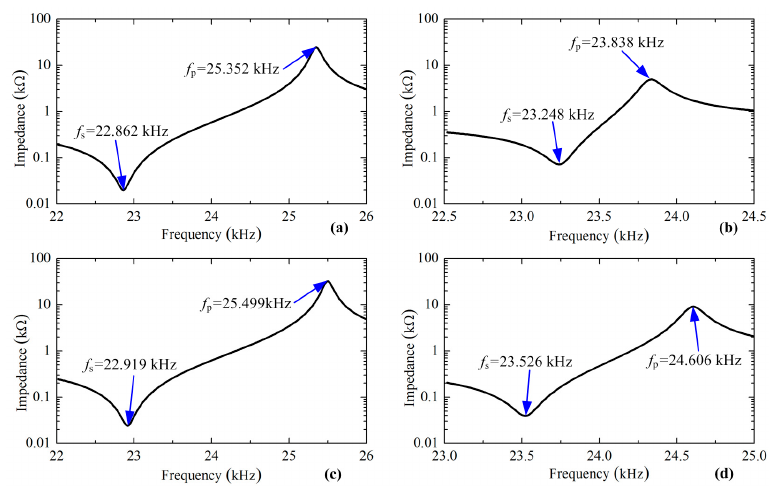
Figure 4. Input impedance characteristics of the transducer under different exciting methods: ( a ) first longitudinal mode under the traditional exciting method; ( b ) second bending mode under the traditional method; ( c ) first longitudinal mode under the new exciting method; ( d ) second bending mode under the new method.